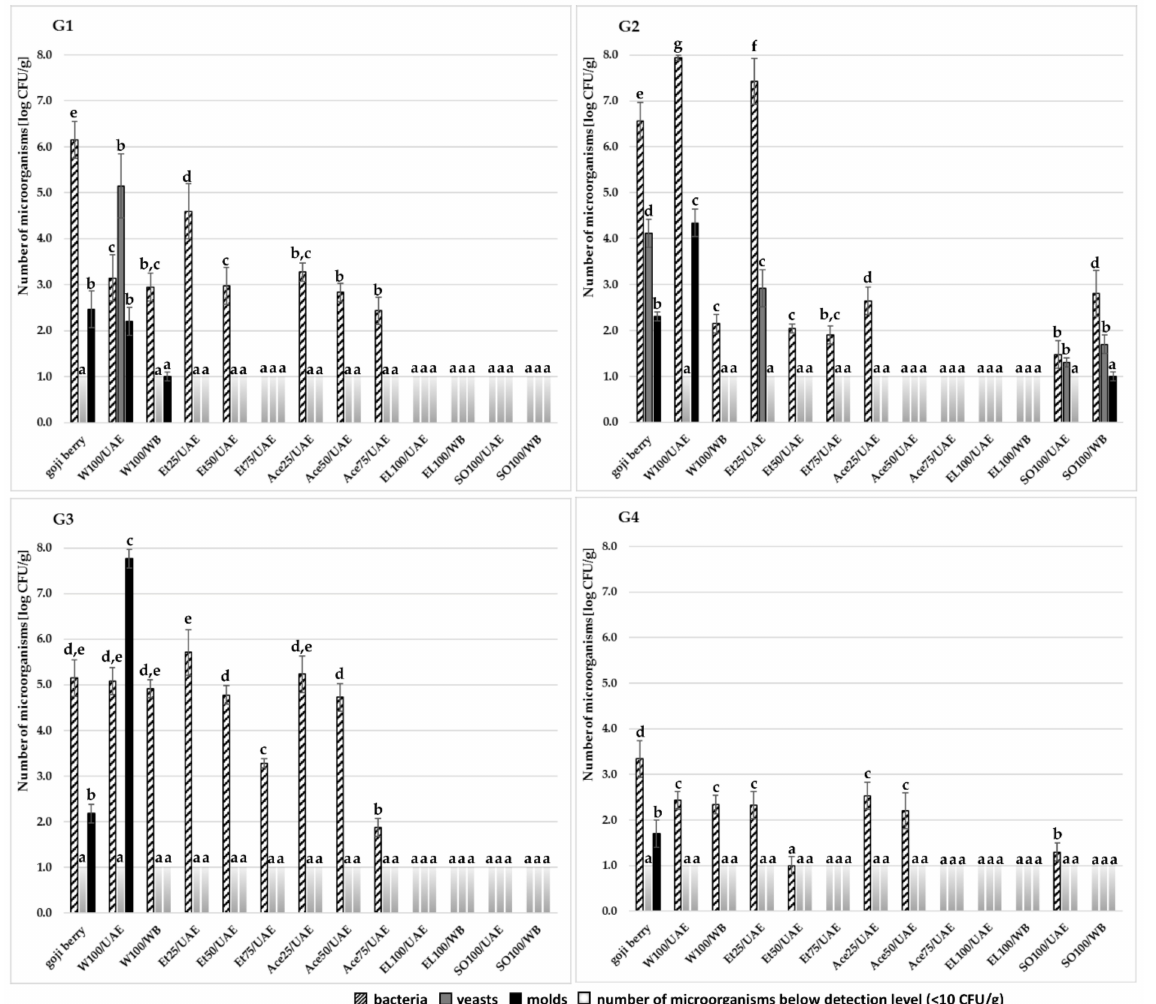
Figure 1. Total number of microorganisms in goji berries and extracts: G1—natural dried goji berries from an unspecified region in China; G2—freeze-dried goji berries from Poland; G3—natural dried goji berries from Ningxia, China; G4—freeze-dried goji berries from Ningxia, China. Means for each group of microorganisms within one goji type followed by the same letter are not significantly different (Tukey’s test, p <